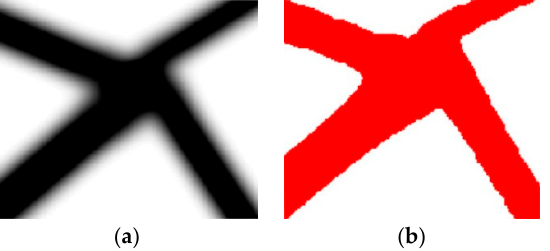
Figure 2. Mesh refining may not eliminate grey elements: ( a ) example of a fine mesh with the presence of grey elements; ( b ) example of a fine mesh without grey elements at boundaries.